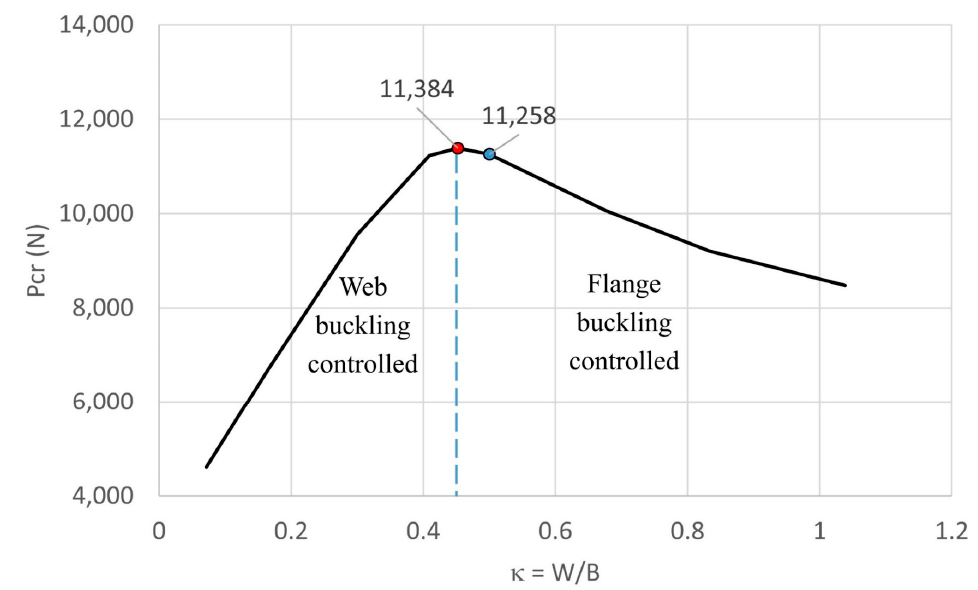
Figure 11. E ff ect of di ff erent dimension ratios on the critical buckling Figure 11. Effect of different dimension ratios on the critical buckling load.